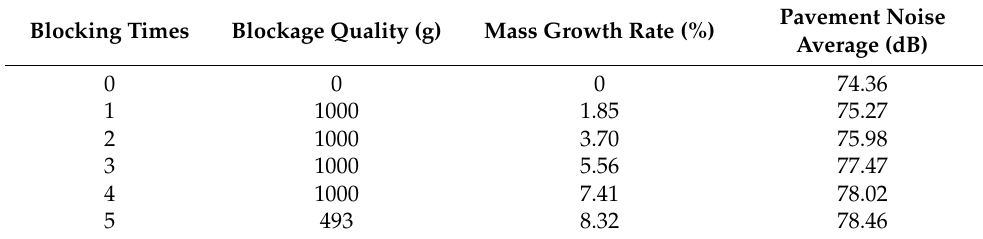
Table 10. Noise changes during